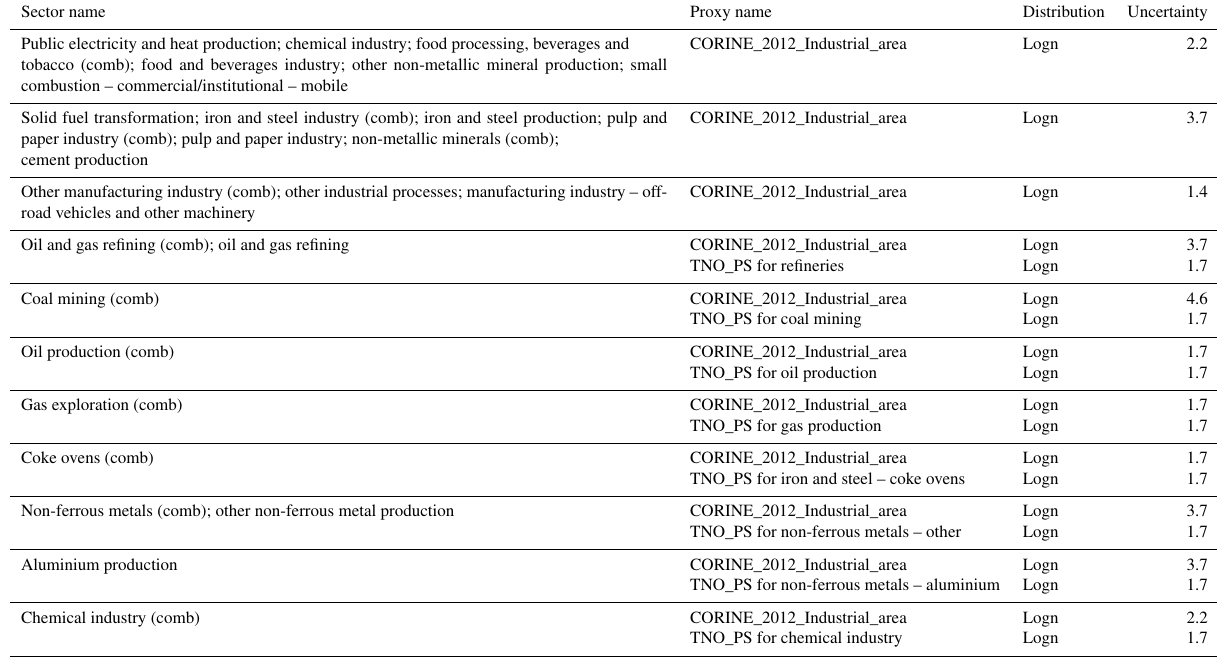
Table A2. Relative uncertainties (fractions) at cell level resulting from the spatial distribution. The values listed represent the (1 standard deviation) uncertainty of the emission per cell due to uncertainty sources 2 and 3 as listed in Sect. 2.2.3. All values in the table below are based on expert quantification and inevitably include a considerable amount of subjectivity. The data should therefore be considered as a first- order indication only. Note that the natural logarithm (Ln) of the uncertainty fraction is given in the event that uncertainty has a lognormal